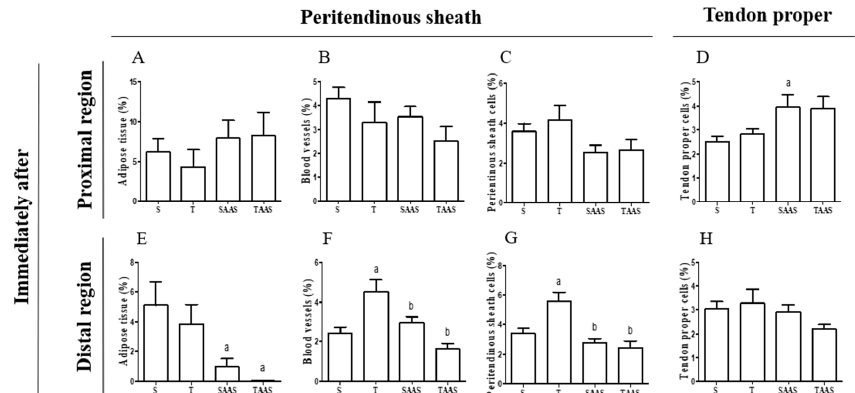
Figure 2. Volume density variation (Vv%) in structural elements found in the proximal and distal regions of the calcaneal tendon (CT) in the IA group and subgroups. Adipose tissue ( A , E ), Blood vessels ( B , F ), Peritendinous sheath cells ( C , G ), Tendon proper cells ( D , H ). Values are expressed as means ± standard error of the mean ( p ≤ 0.05). ( a ) Significant difference vs. S subgroup, ( b ) significant difference vs. T subgroup.